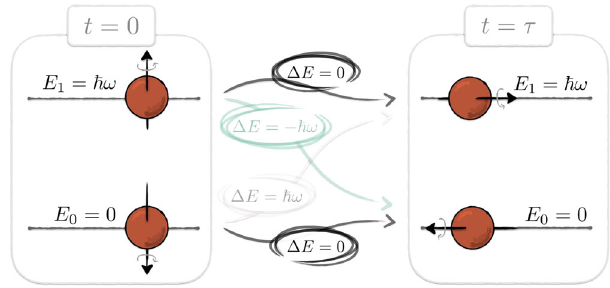
Fig. 3 Two-point measurement scheme in the forward process for our particle in the thermal state of the initial spin- 1 system. A spin- 1 (cid:2) (cid:3) 2 2 (cid:2) Hamiltonian is measured in its eigenbasis f z g at time t = 0. After the ± action of the quench described by the time-dependent Hamiltonian in Eq. (cid:2) (cid:3) (cid:2) (25), it is measured in the eigenbasis f x g of the fi nal Hamiltonian at time ± t = τ . Depending on the measured states at the two times, the thermodynamic quench causes an energy change Δ E = 0, ± ℏ ω , with ω being the spin ’ s natural frequency, and ℏ the reduced Planck